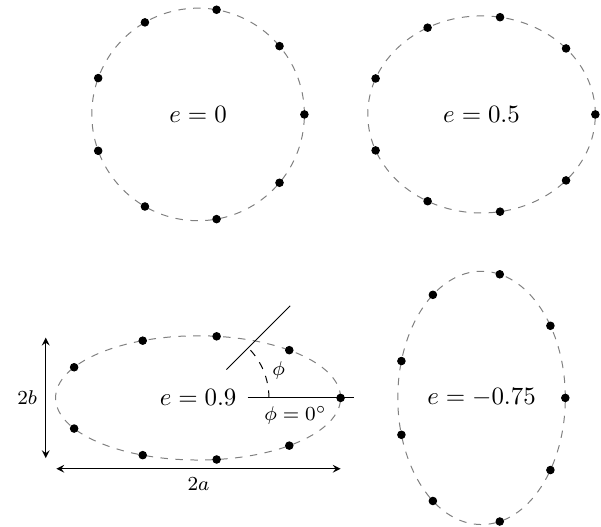
Figure 8. The shape of the deformed UCAs for different values of e